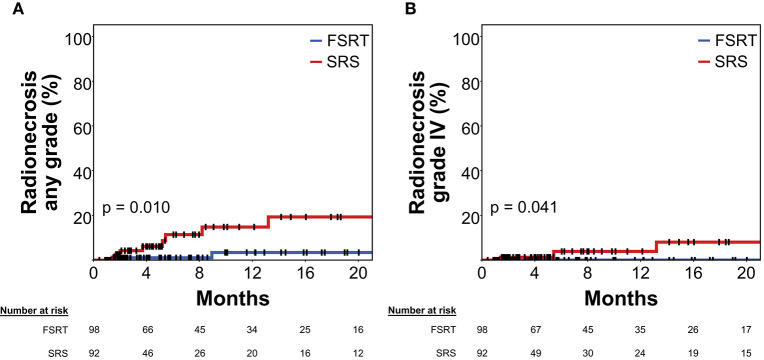
Rate of radionecrosis of any grade (A) and grade IV radionecrosis (B) in 92 brain metastases treated with SRS (red) and 98 brain metastases treated with FSRT (blue). Log-rank p = 0.010 and p = 0.041, respectively. Radionecrosis was defined volumetrically or as tissue diagnosis showing radionecrosis after radiotherapy (see Methods section for details). As radionecrosis grade IV is defined as requiring surgical intervention, all events shown in (B) had histologic proof of radionecrosis. Vertical lines represent censored cases. SRS, Stereotactic radiosurgery; FSRT, Fractionated stereotactic radiotherapy.